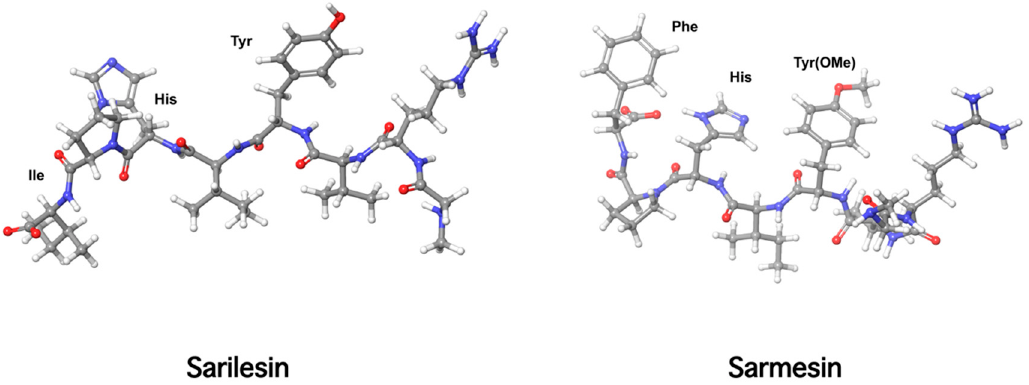
Figure 7. 3D structures of sarilesin and sarmesin.